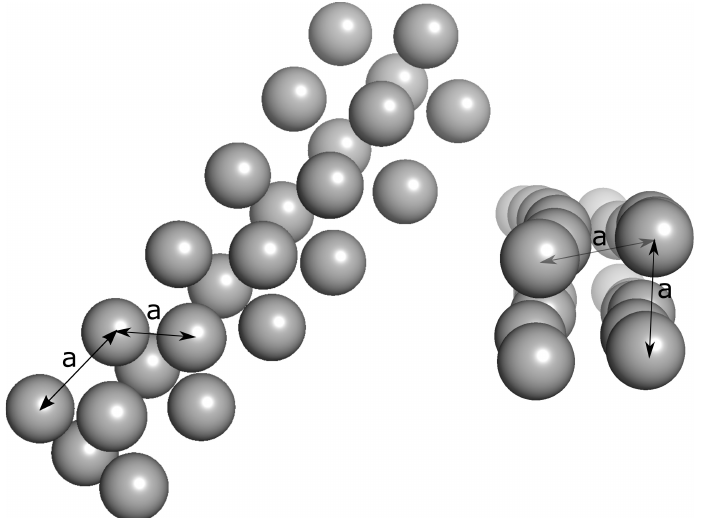
Figure 7. Simulation snapshots of the self-assembled tubular structures by the aromatic amino acids. The length a between C α atoms is measured as 5.0 ± 0.3nm.